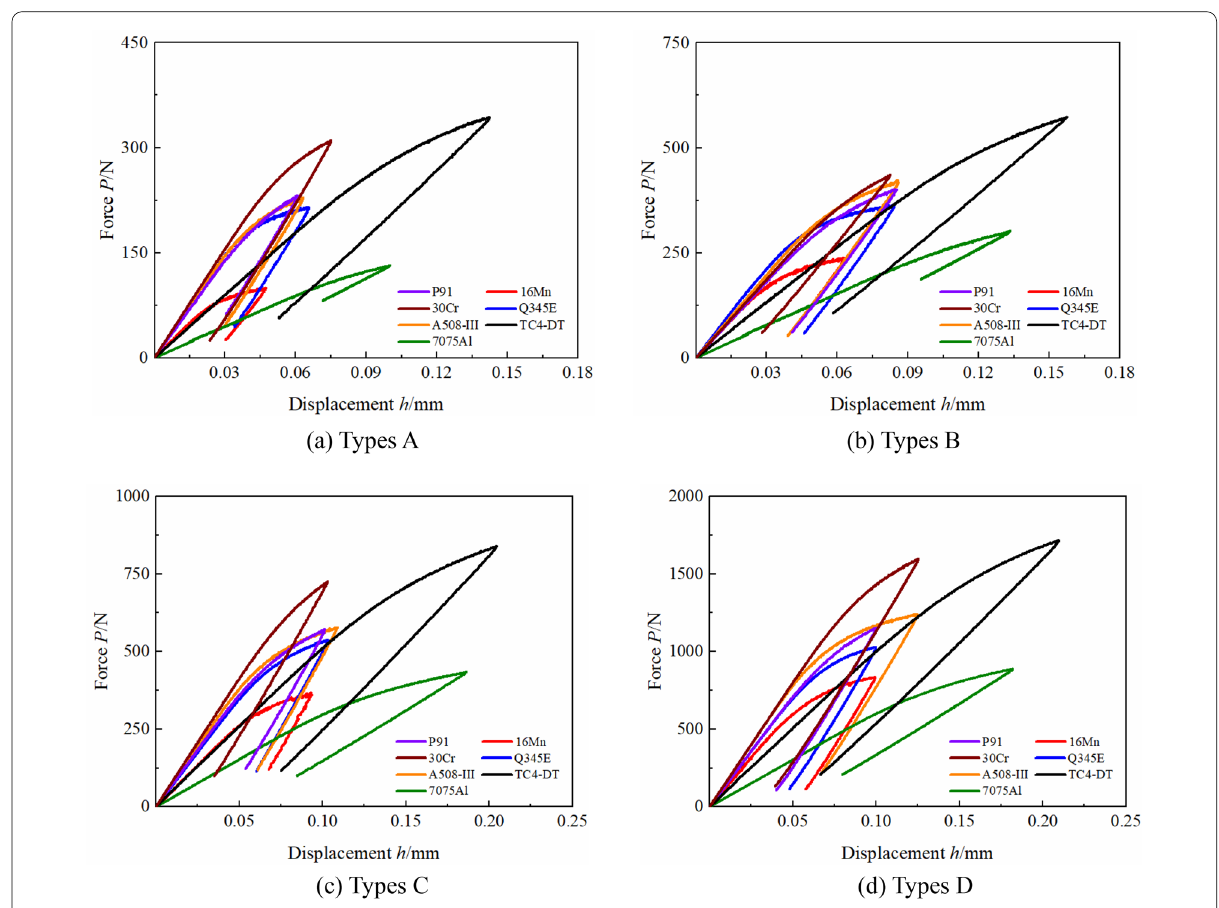
Figure 11 Load–displacement curves of loading–unloading